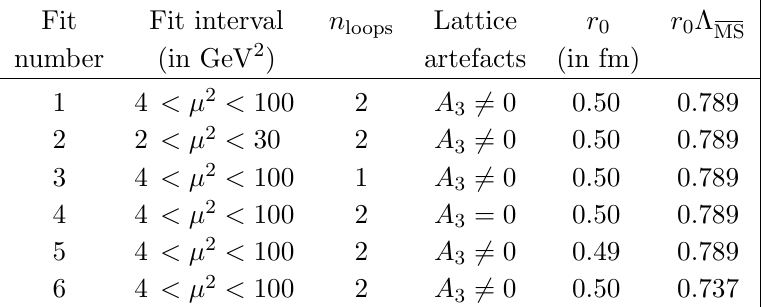
and f T , respectively, (cid:26) (cid:26)